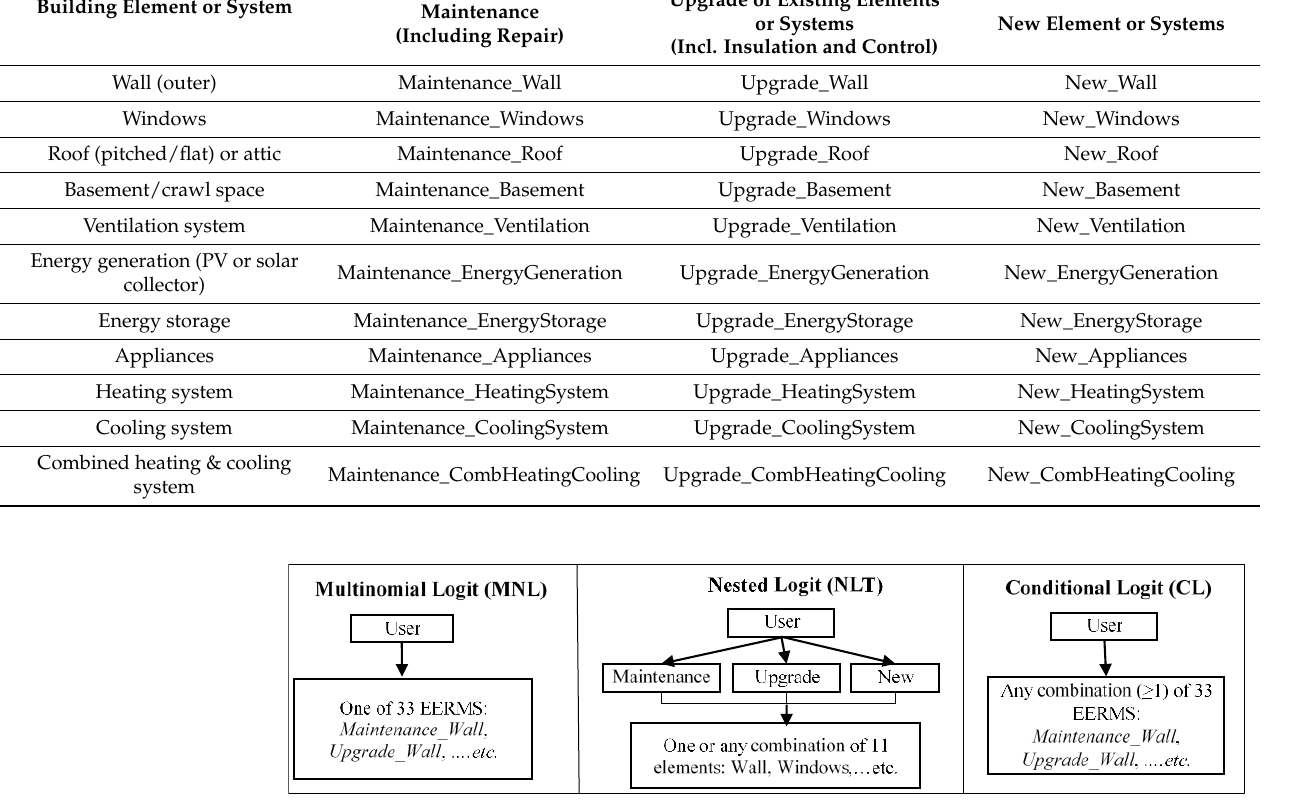
Figure 1. Model selection. Figure 1. Model Table 4. Distribution of combination of choices per each element (out of 11) chosen.